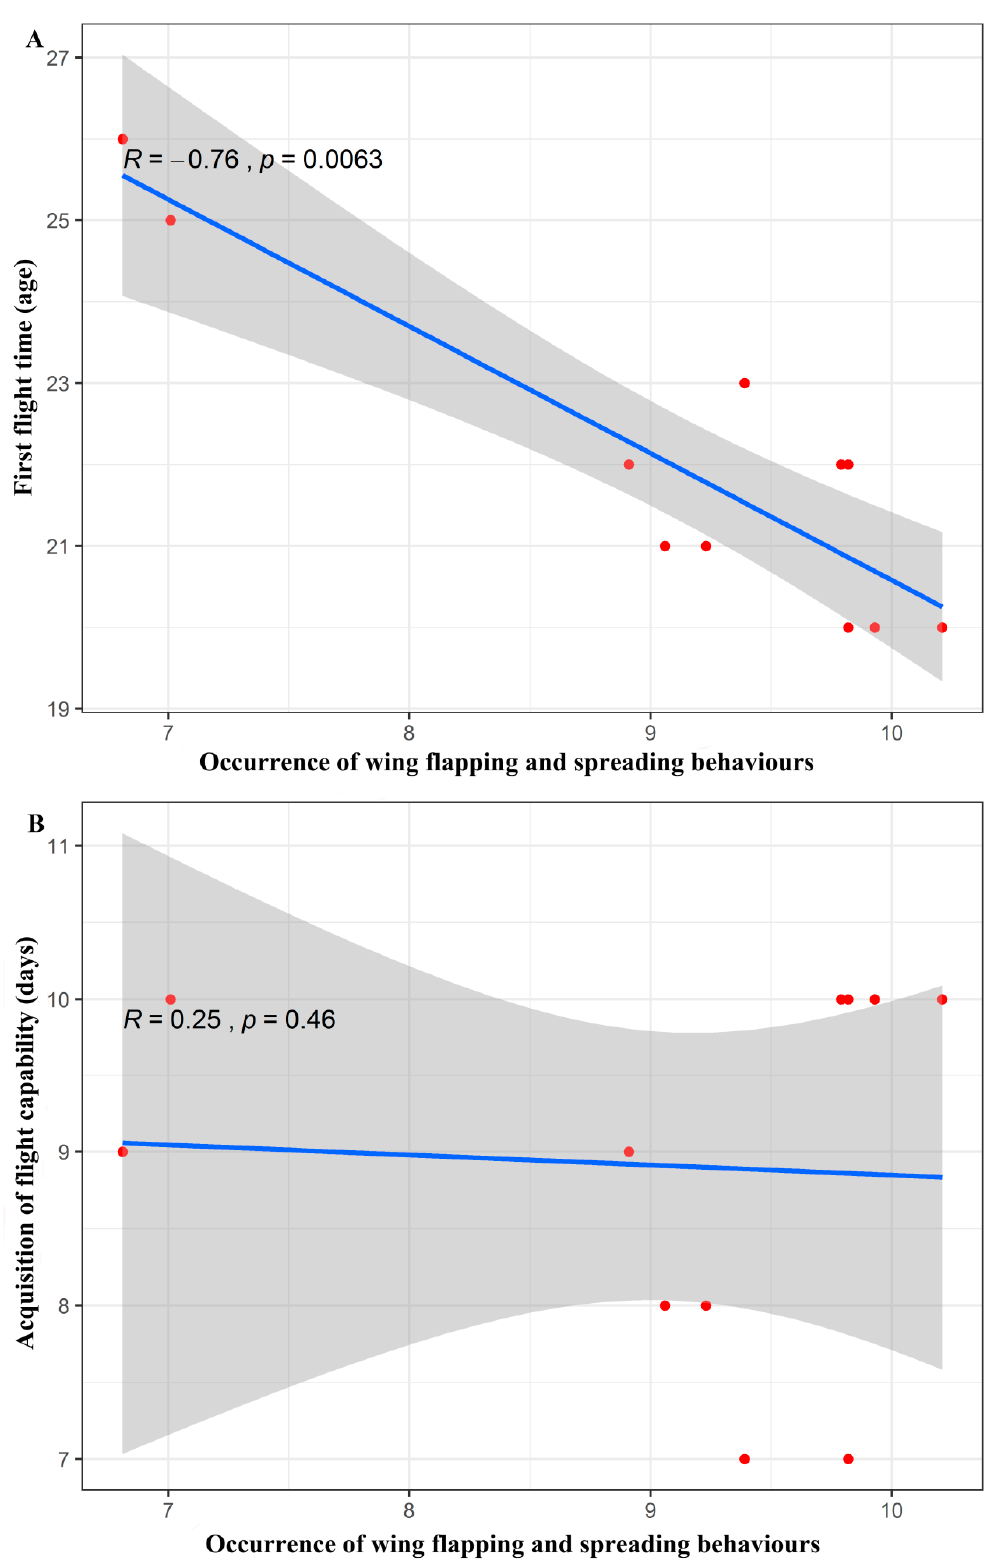
Figure 8. ( A ) Scatter plot of the correlation between the occurrence of the wing flapping and spreading behaviours and the age at which the young Asian parti-coloured bats ( Vespertilio sinensis ) performed their first flights. ( B ) Scatter plot of the correlation between the occurrence of the wing flapping and spreading behaviours and the time at which the ability to fly was acquired. The solid blue lines represent the fitted curves, and the shadowed areas represent the 95% confidence interval.